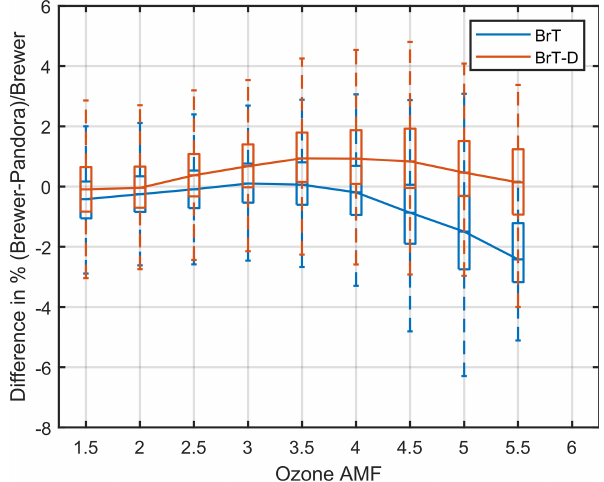
Figure A2. The percentage difference between Pandora and Brew- ers (grouped as BrT and BrT-D) as a function of ozone air mass factor. On each box, the central mark is the median, the edges of the box are the 25th and 75th percentiles, and the whiskers extend to the most extreme data points not consider